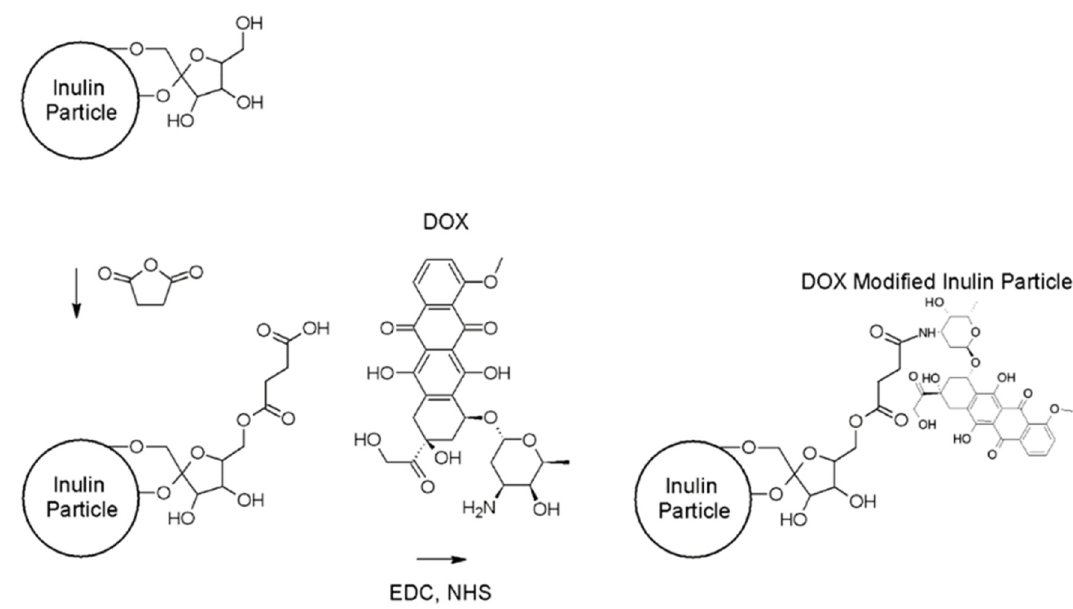
Figure 1. Doxorubicin-modified microparticulate inulin (MPI).